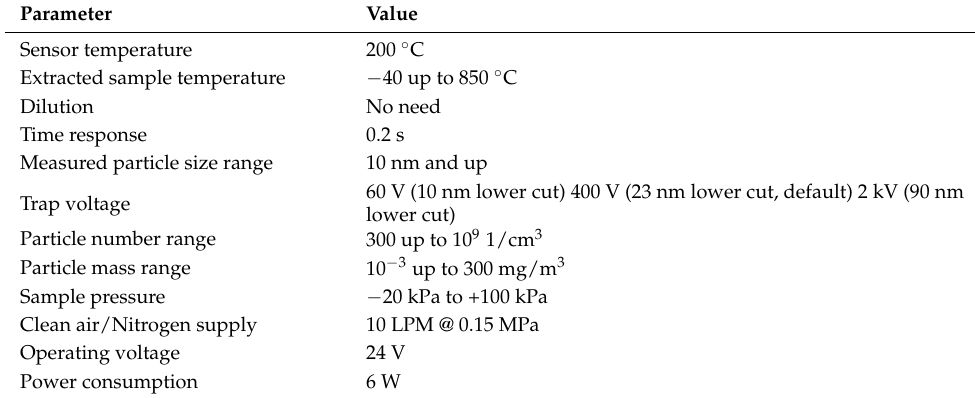
Table 2. The PPS-M sensor specifications.